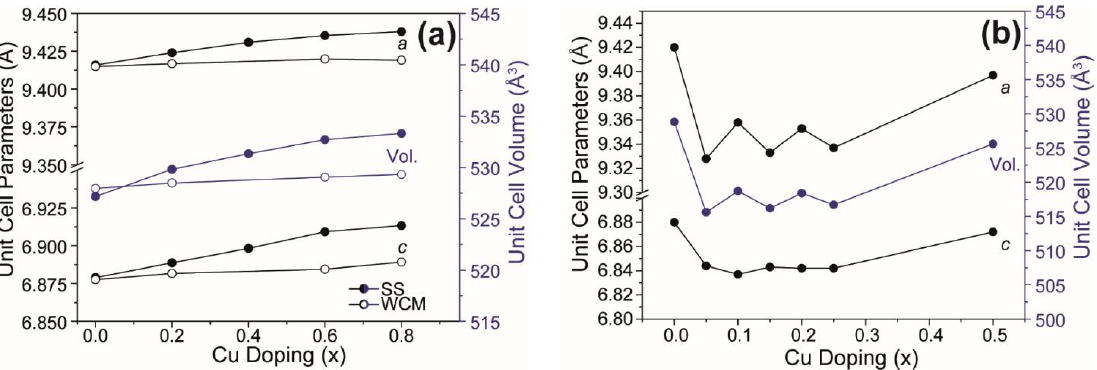
Figure 3. Unit cell and volume parameters ( a ) as determined from the PXRD for Ca 10 (PO 4 ) 6 [Cu x (OH) 2-2x O x ] (0 ≤ x ≤ 0.8) generated by the solid-state and wet chemical synthesis methods in this work, compared with ( b ) the same parameters from Cu-doped systems generated by Shanmugam et al. [24].